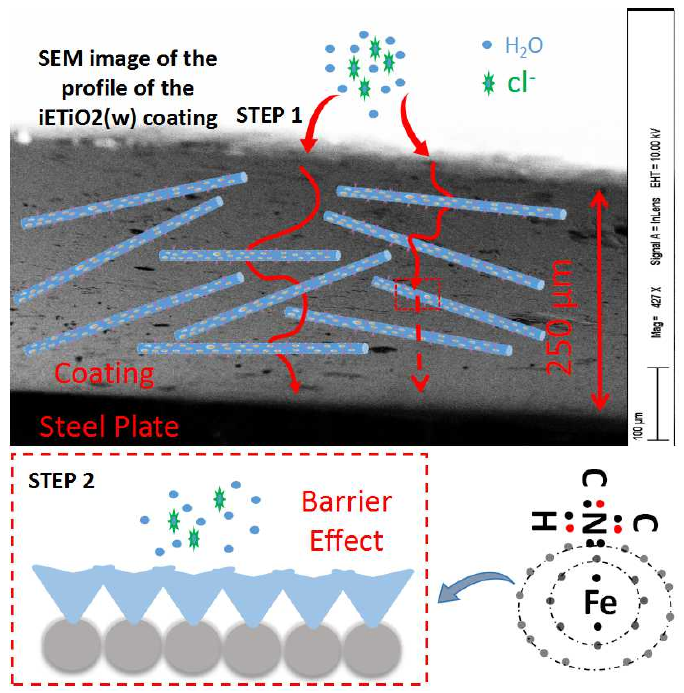
Figure 12. The corrosion protection mechanism of an iETiO 2 (w) epoxy coating.